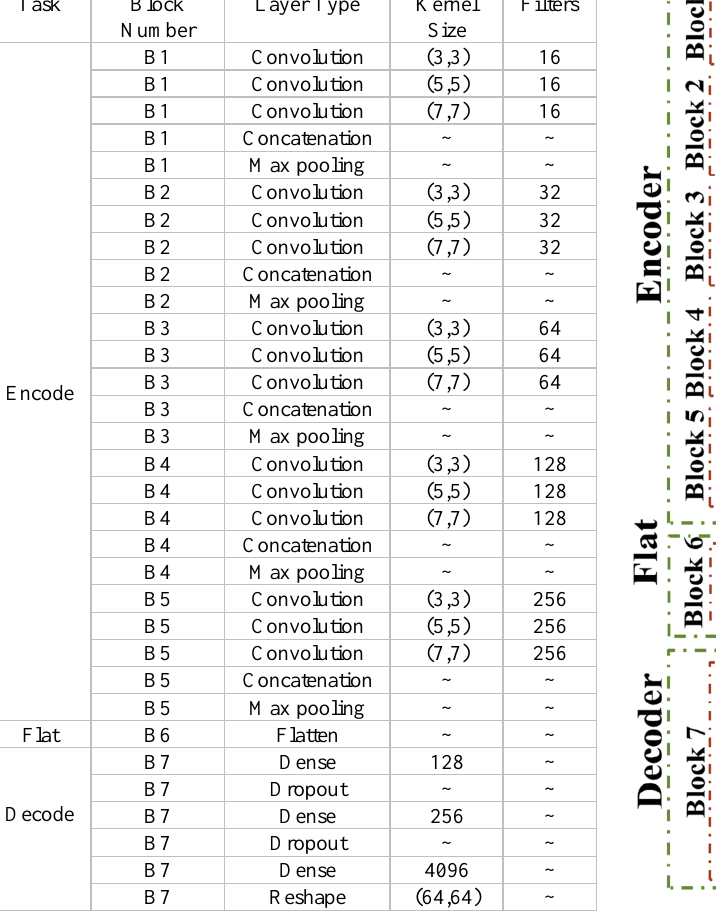
Table 1 . The structure of the multi-kernel CNN model. Figure 3 . The proposed CNN architecture in this